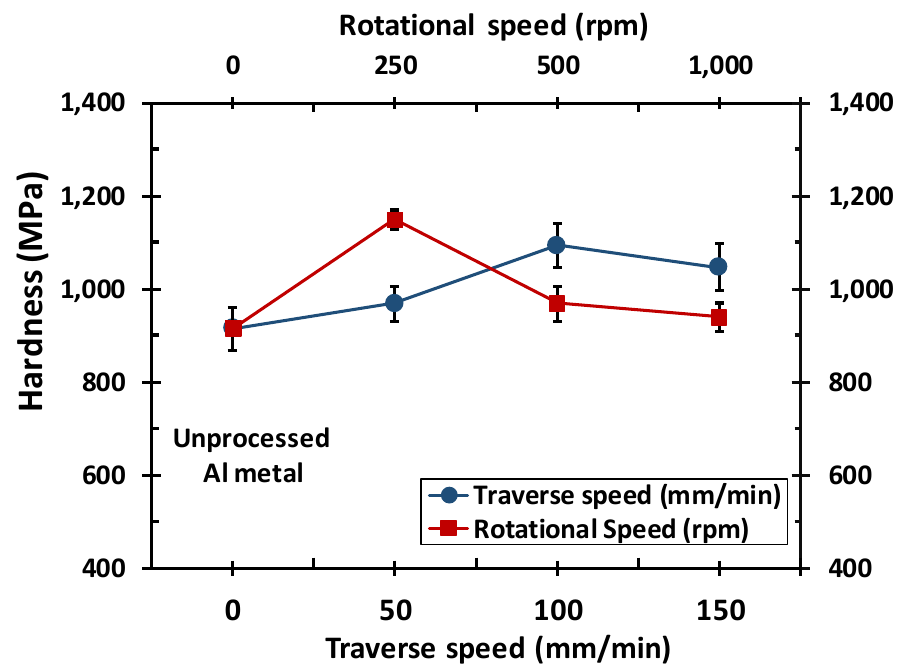
Figure 6. Microindentation hardness of the stirred zone as a function of the rotational and traverse